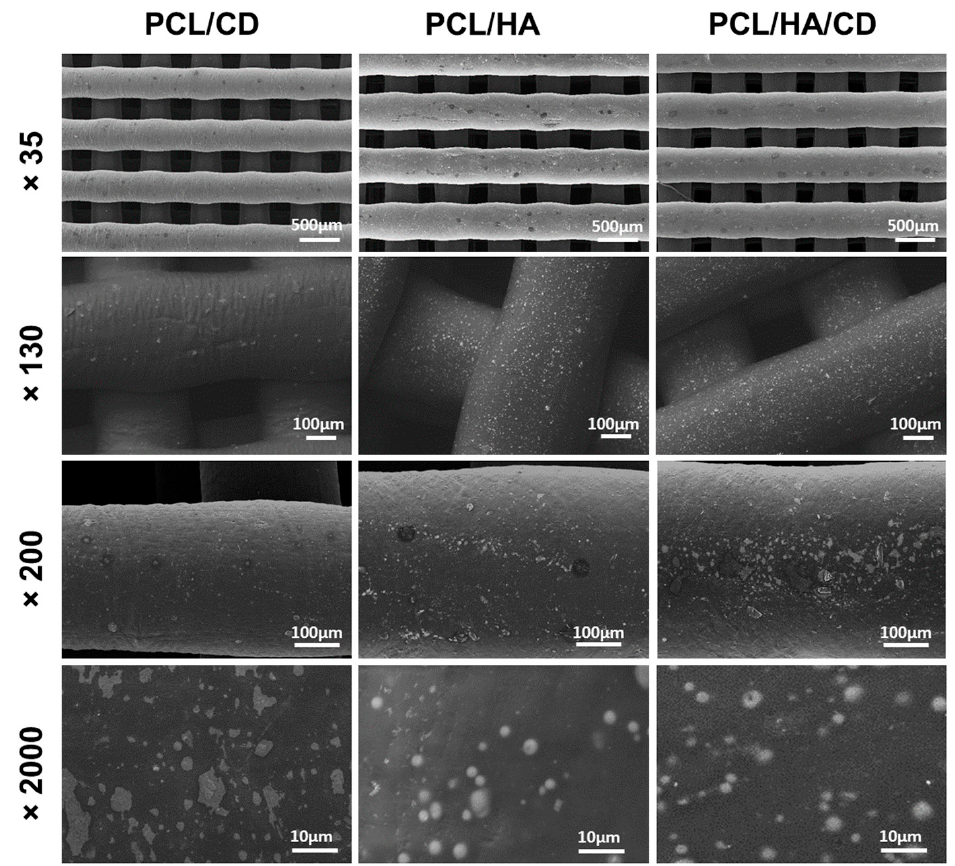
Figure 4. SEM micrographs at different magnifications (×35, ×130, ×200 and ×2000) of composite PCL/CD (left column), PCL/HA (middle column), and PCL/HA/CD (right column) scaffolds.